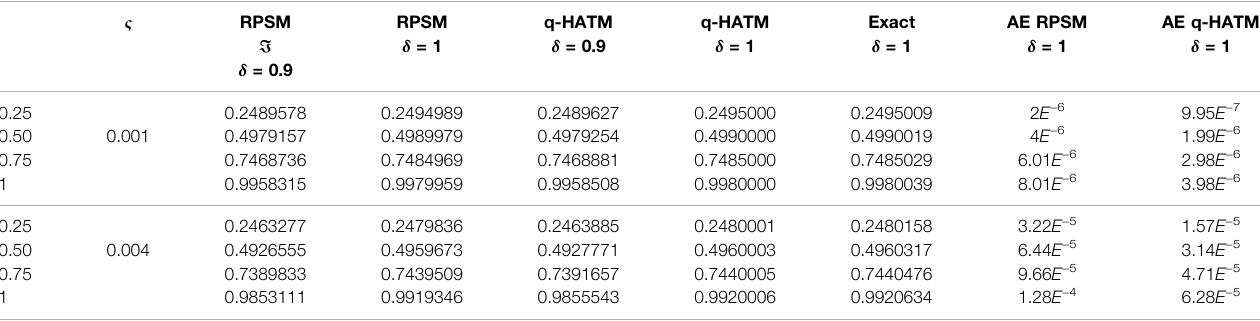
TABLE 2 | A comparison of RPSM, q-HATM and exact for various values of ς and I